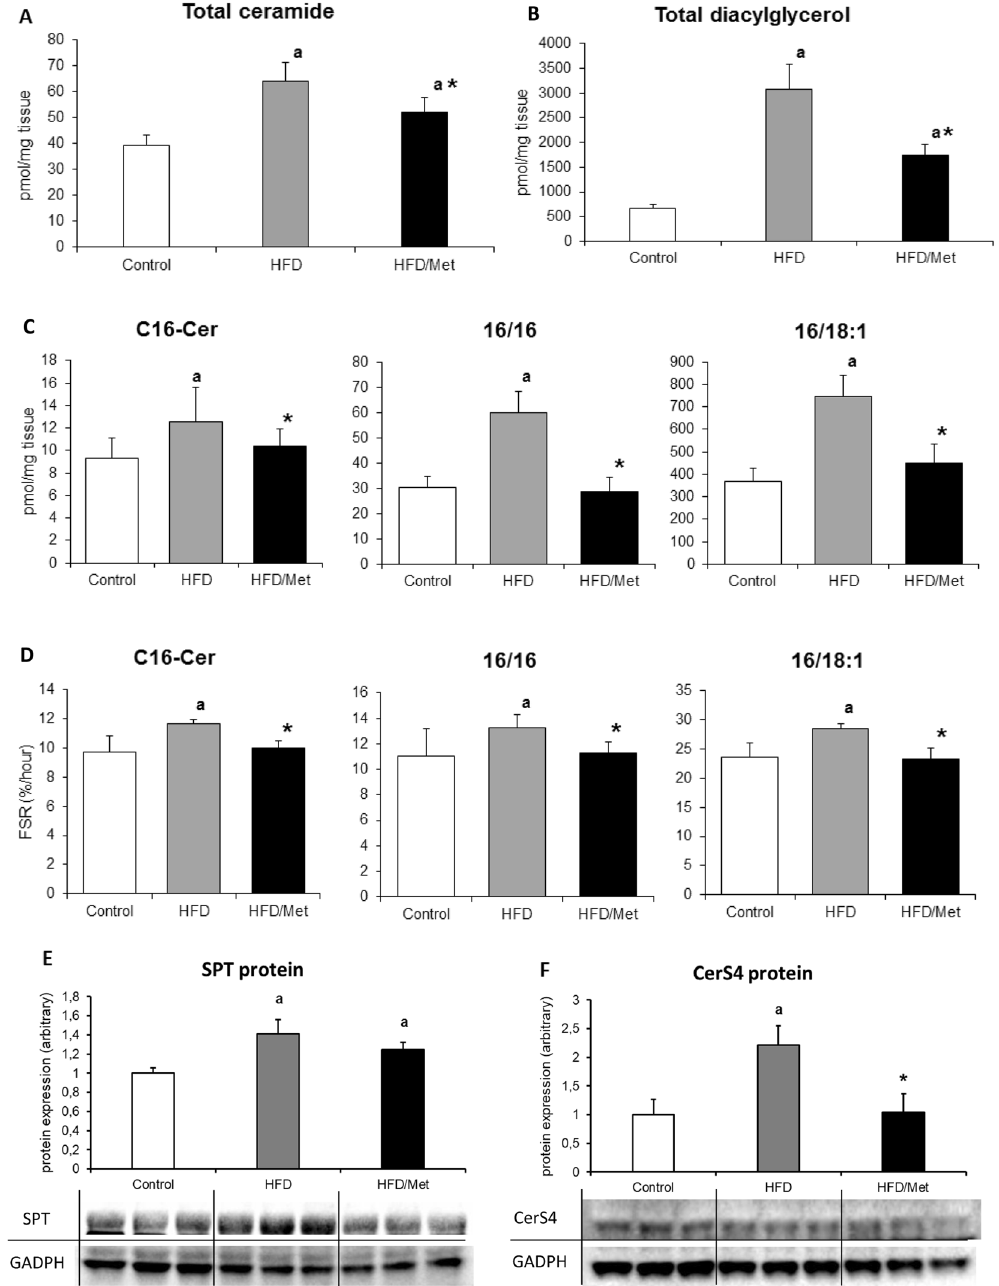
Figure 3. Metformin treatment normalizes hepatic content an synthesis rate of ceramide and diacylglycerol in the liver of rats fed HFD diet. Panel A and B present a total ceramide and diacylglycerol content in rat liver, respectively; Panels in the C row show the content of ceramide and diacylglycerol molecular species with established FSR. Panels in the D row present respective FSR values of the individual lipid species from the panels in the C row. Panel E and F present hepatic protein content of SPT and CerS4. Values are mean + / − SD. Symbols denote statistical significance of p < 0.05 versus: a- vs. Control group; * - vs. HFD group. n = 8 per group; Significance by Anova with Tukey HSD post-hoc